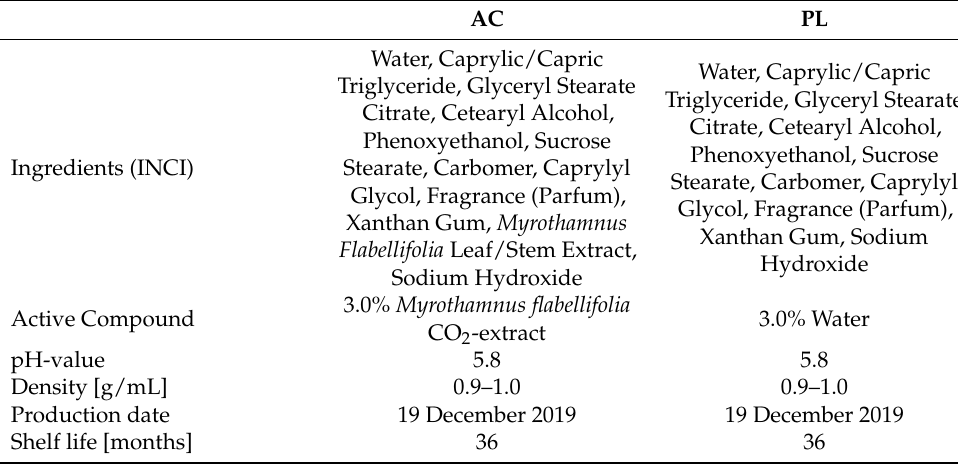
Table 1. Characterization of the samples (AC = active compound, PL =